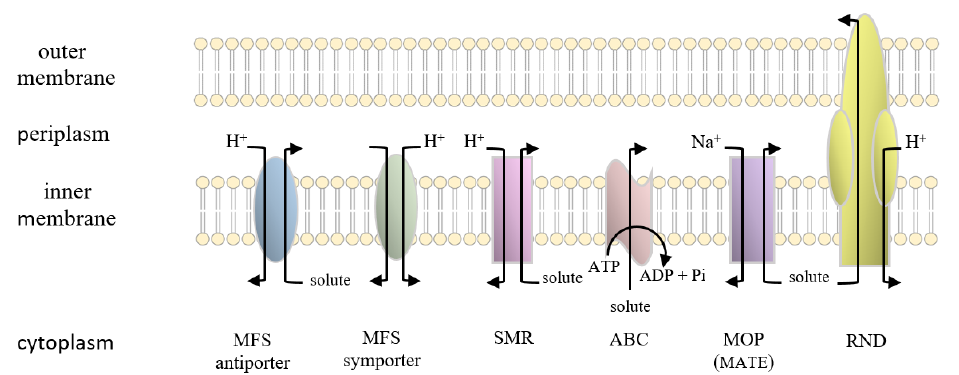
Figure 1. Superfamilies and families of solute transporters. Shown are the outer and inner bacterial membranes with graphic representations of solute transporter superfamilies and families. MFS denotes the major facilitator superfamily; SMR, small multi-drug resistant family; ABC, ATP-binding cassette transporter superfamily; MOP (referred to previously as MATE), multidrug / oligosaccharidyl-lipid / polysaccharide flippase superfamily; RND, resistance-nodulation-cell division superfamily. H + and Na + denote protons and sodium ions, respectively. Courtesy of Ann Varela.